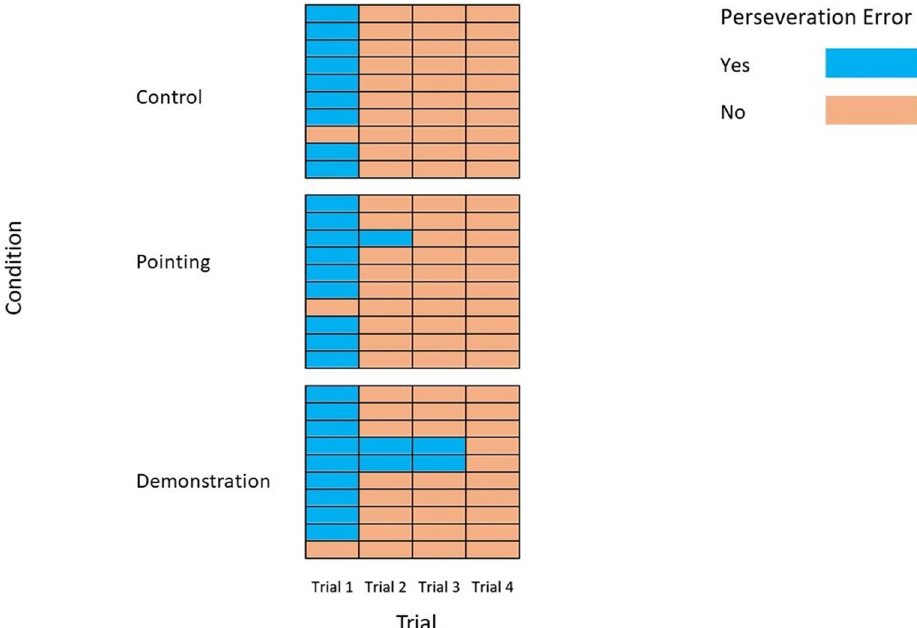
Figure 1. Dogs in all conditions were equally likely to commit the perseveration error on the first trial and as likely to learn to avoid committing it over all four trials. Each separate block represents a condition (with 10 dogs in each condition.) Each row represents an individual dog and each column represents an individual trial. 9/10 dogs in each condition showed the perseveration error on the first